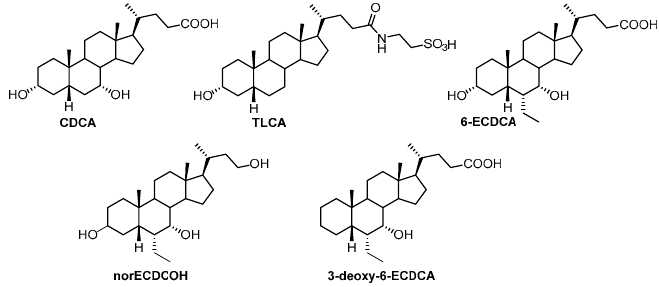
Figure 1. Representative structures of steroidal FXR or GPBAR1 agonists.